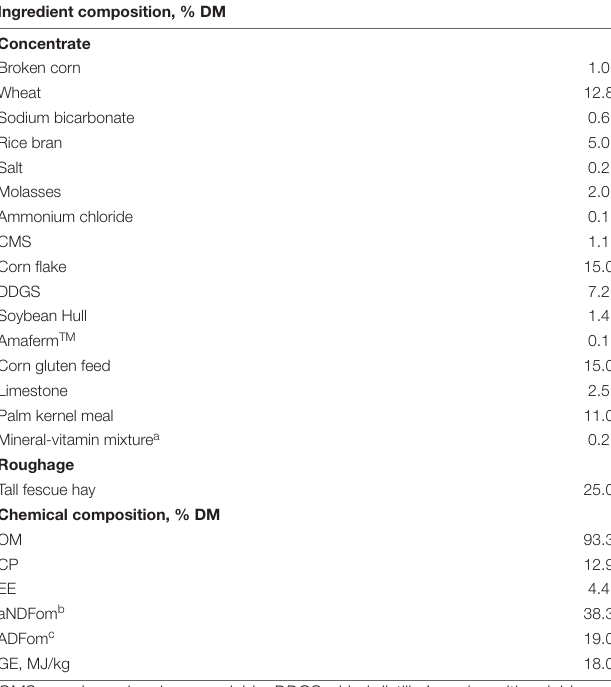
TABLE 1 | Ingredients and chemical composition of the basal diet used in the experiment. Ingredient composition, % DM Concentrate Broken